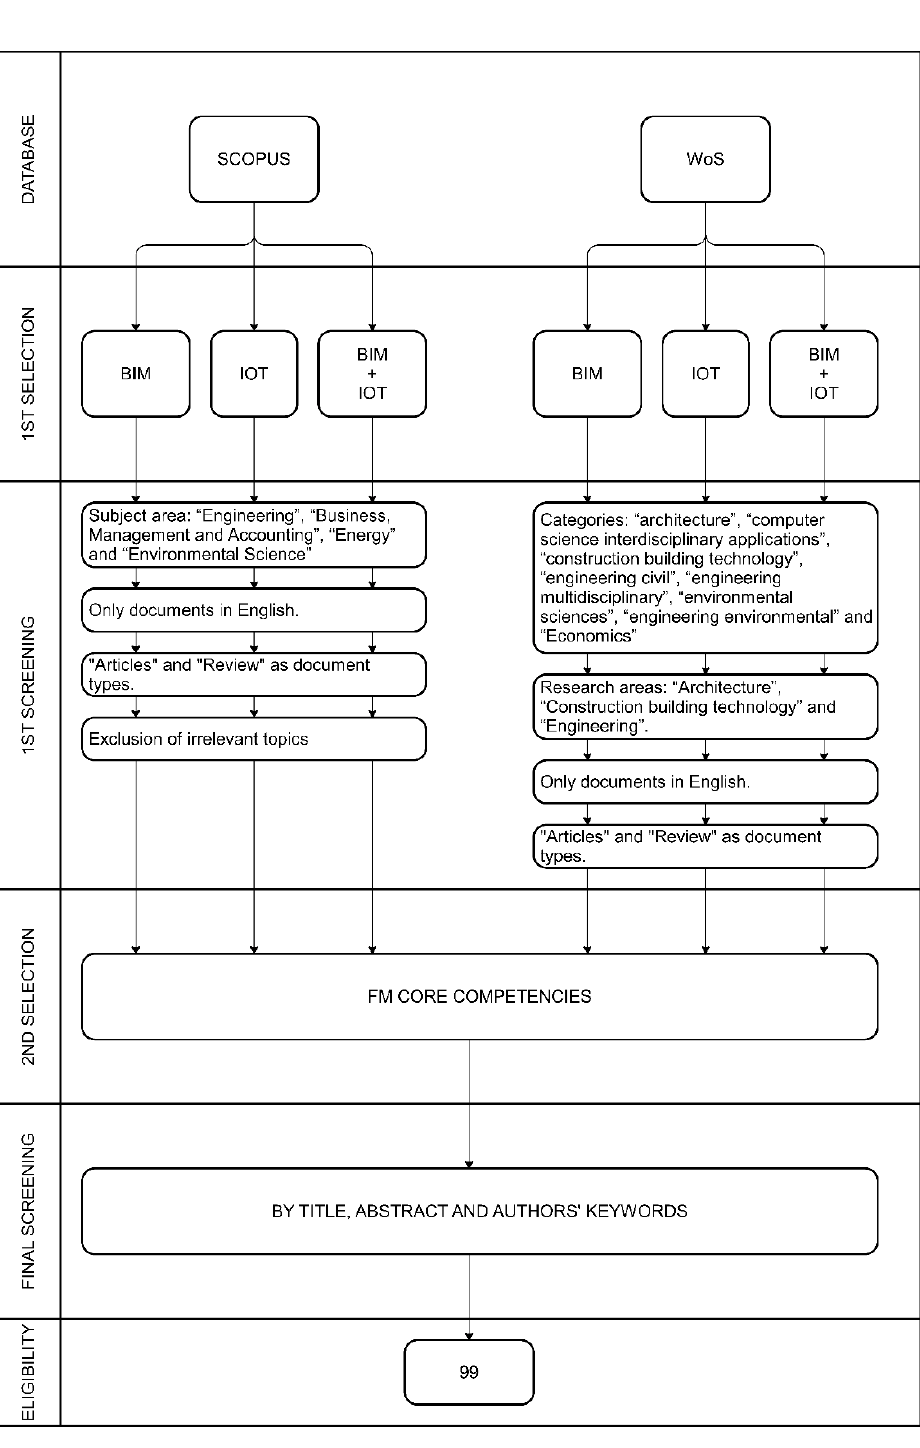
Figure 1. Research Figure 1. Research methodology.